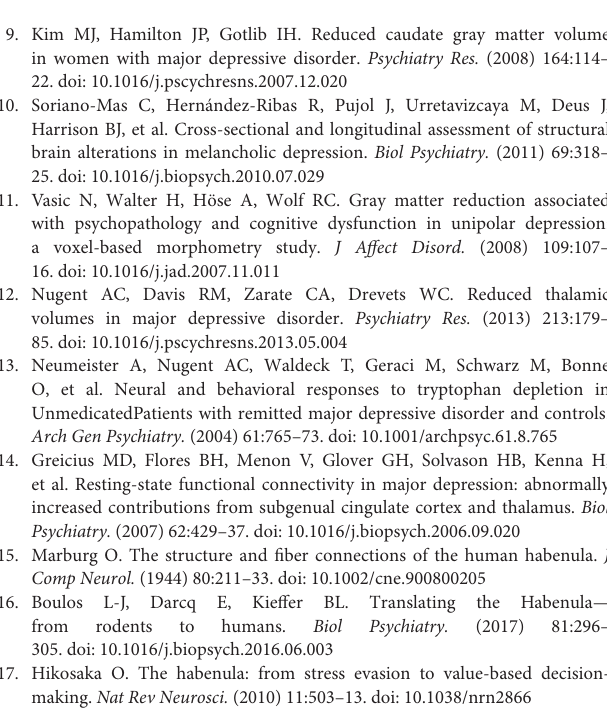
Supplementary Figure 1 | Segmented habenula, indicated with a red, overlaid on a T1 template image. (A) Axial, coronal, and sagittal images for indicating the segmented habenula. (B) Consecutive axial images covering the habenular